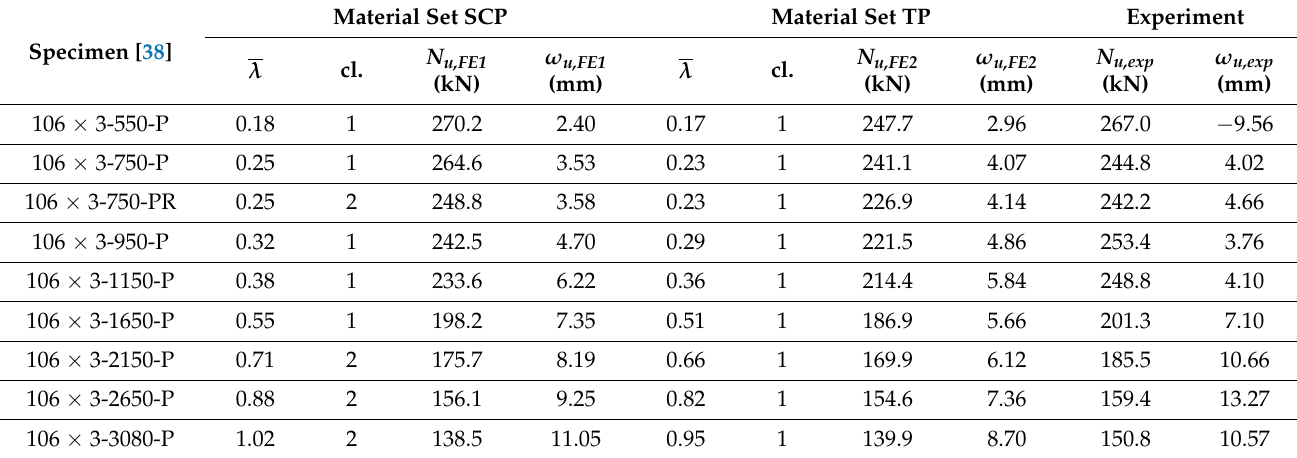
Table 13. Approach #D, FEA and experiment results of the cross-section set 106 × 3 CHS pin-ended columns.